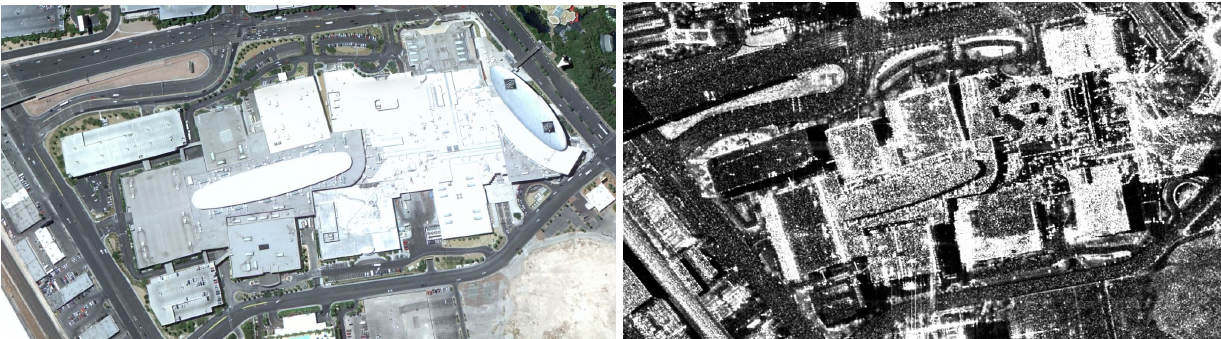
Figure 2. Example building: the Fashion Show Mall. Left: optic image in Google-earth; right: Mean intensity map from a stack of high resolution TerraSAR-X images